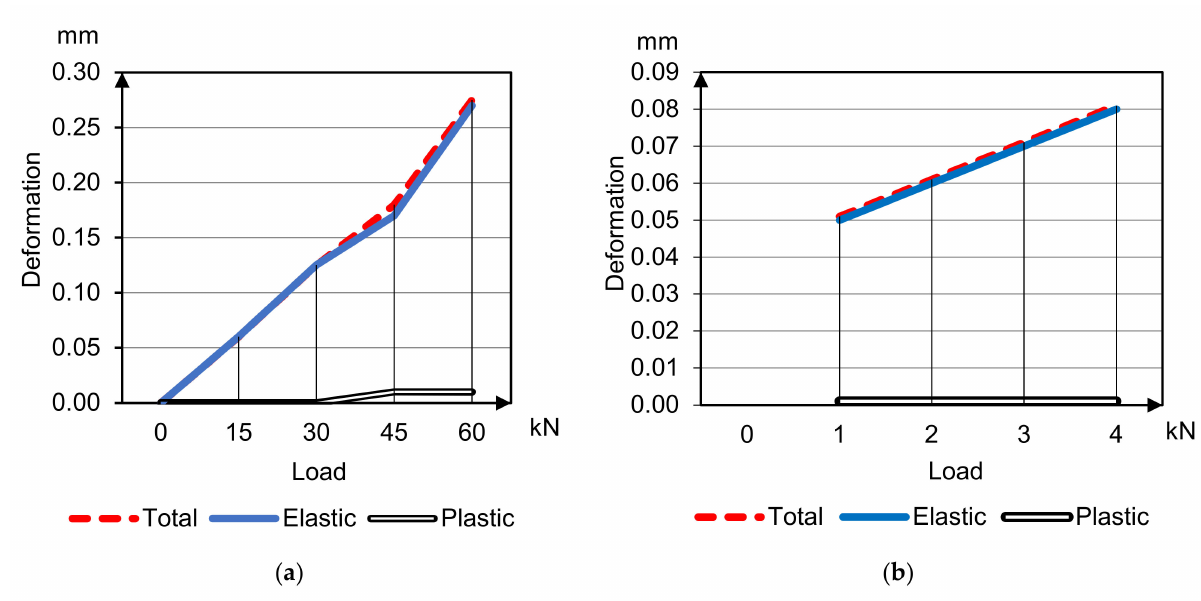
Figure 8. Deformation and deflection curves for concrete 3 under compression ( a ) and bending ( b ) tensile.